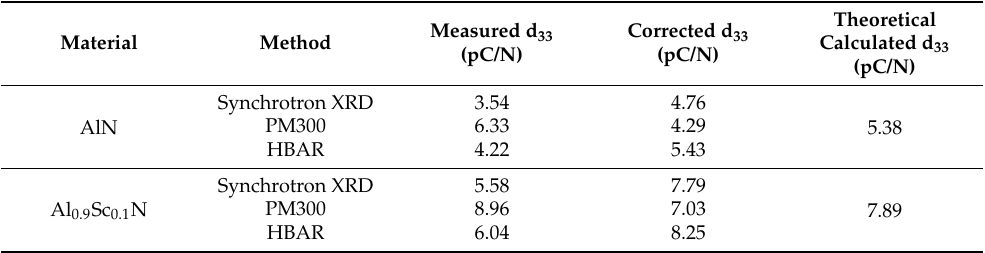
Table 1. The measured and corrected d 33 of AlN and Al 0.9 Sc 0.1 N films from synchrotron XRD, PM300, HBAR and theoretical